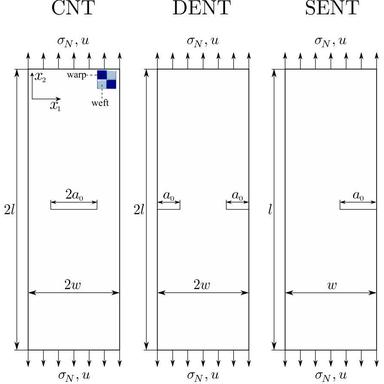
Three notched specimen geometries (CNT, DENT, SENT) under a uniaxial nominal stress σN, imposed by a boundary condition of uniform remote displacement, u.